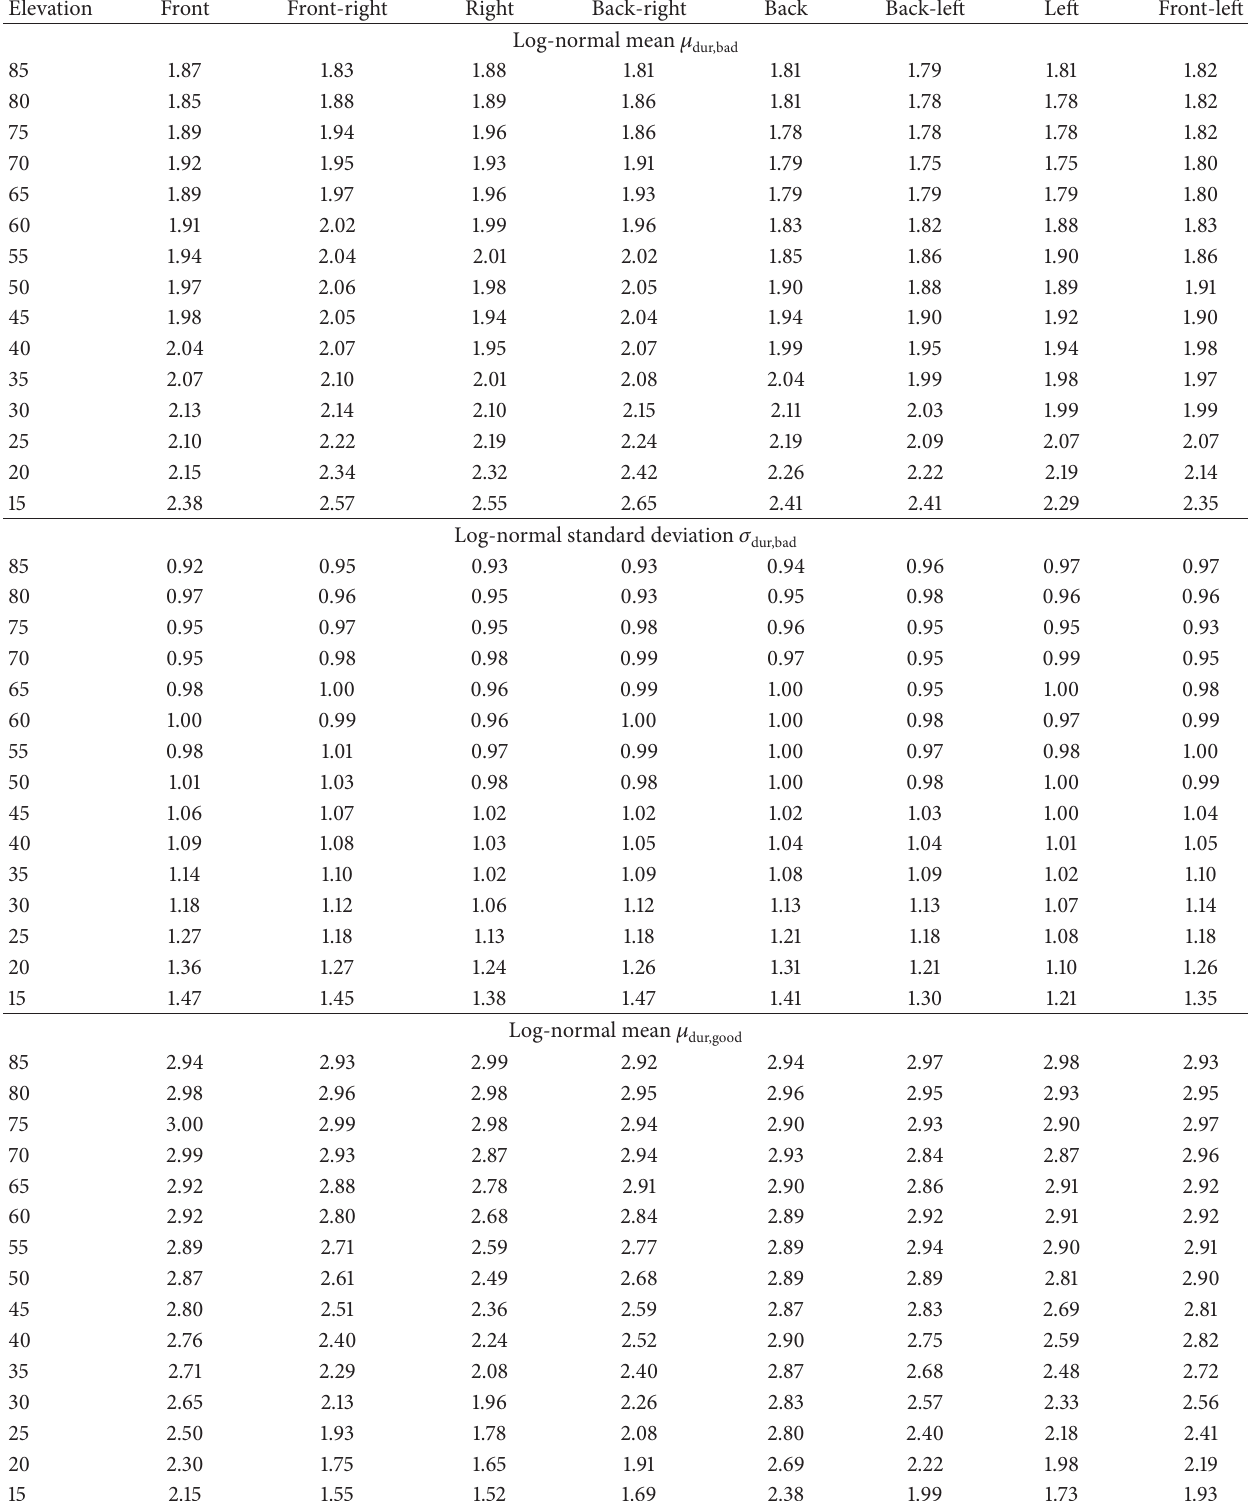
Table 3: Semi-Markov parameters ( good and bad state) for suburban environment for variable driving directions and elevations. Elevation Front Front-right Right Back-right Back Back-left Left Front-left Log-normal mean 𝜇 dur,bad